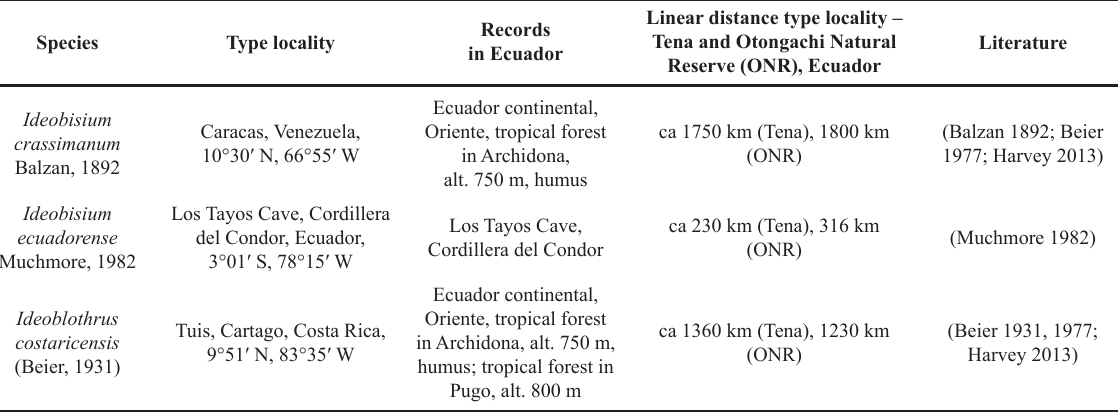
Table 2. Previously recorded species of Ideobisium Balzan, 1892 and Ideoblothrus Balzan, 1892 in Ecuador, their type localities and sampling